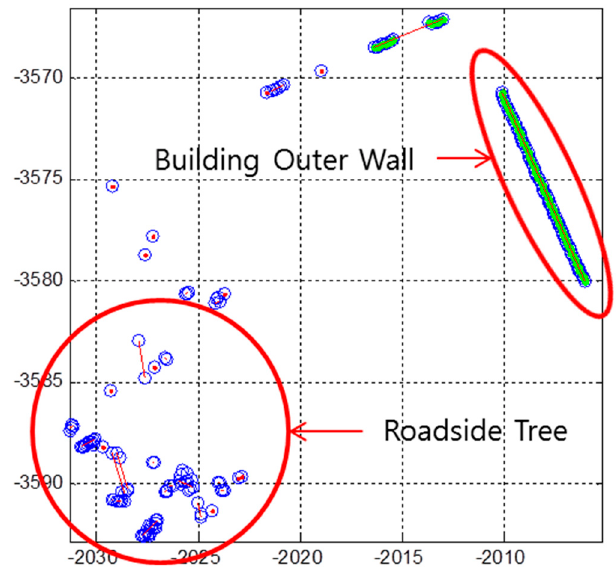
Figure 4. Laser scanning points reflected by the leaves of roadside trees and the outer wall of the building.